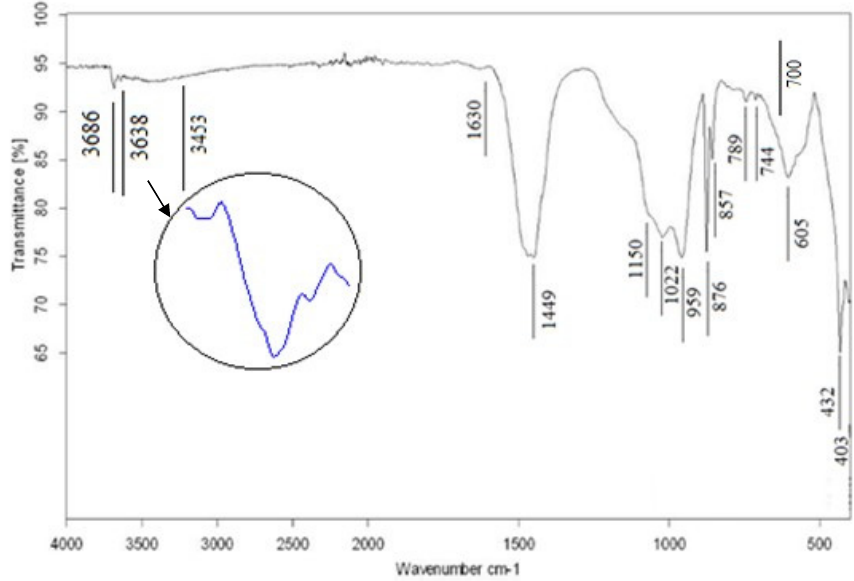
Figure 5. Fourier transform infrared (FTIR) spectrum of AC waste sample.